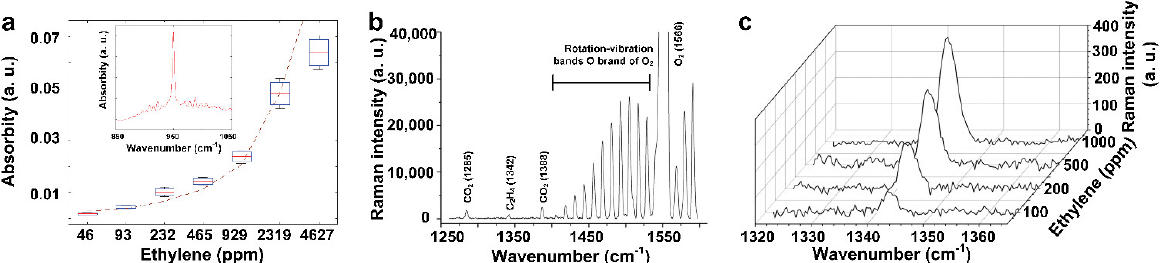
Figure 2. ( a ) Relationship of the absorbity versus the concentration of ethylene gas. Inset: the characteristic absorption spectra, with peaked absorption at the wavenumber of ~949 cm −1 . Reproduced from Ref. [62] with permission from the IEEE. ( b ) Raman spectrum of 250 ppm of ethylene gas mixed with 20% O 2 and 500 ppm CO 2 , and ( c ) the spectral intensity of ethylene’s vibration band (1343 cm −1 ) against its concentrations in a mixture of 20% O 2 and 500 ppm CO 2 . Reproduced from Ref. [31] with permission from the Royal Society of